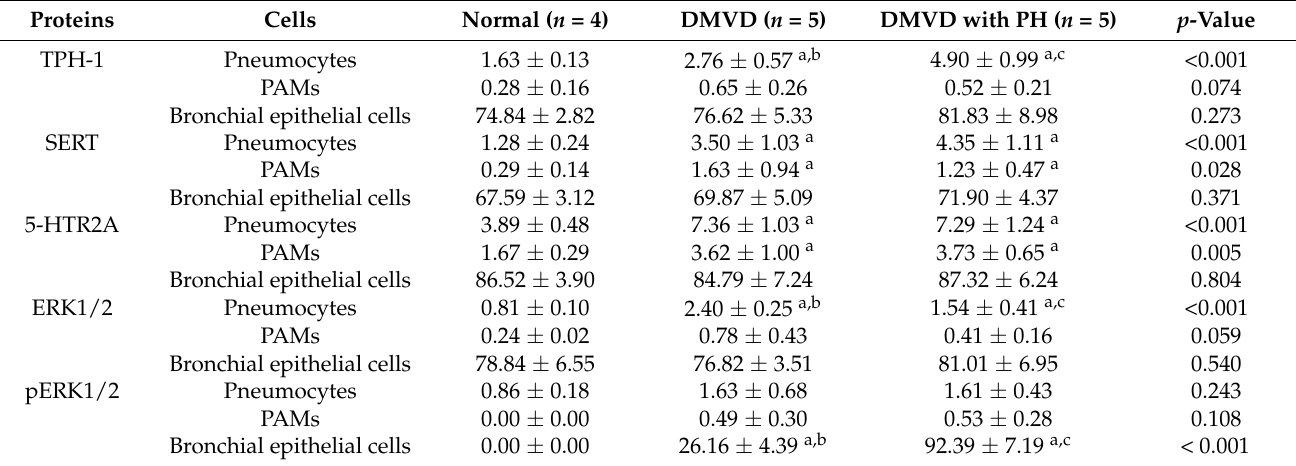
Figure 2. The cytoplasmic expression of TPH-1, SERT and 5-HTR2A in pneumocytes of alveoli PAMs (top row) and bronchial epithelial cells (bottom row) of dogs in the control ( a , d , g , j , m , p ), de- generative mitral valve disease (DMVD) ( b , e , h , k , n , q ) and degenerative mitral valve disease with pulmonary hypertension (DMVD with PH) groups ( c , f , i , l , o , r ) presented as brown color (Labeled tion).